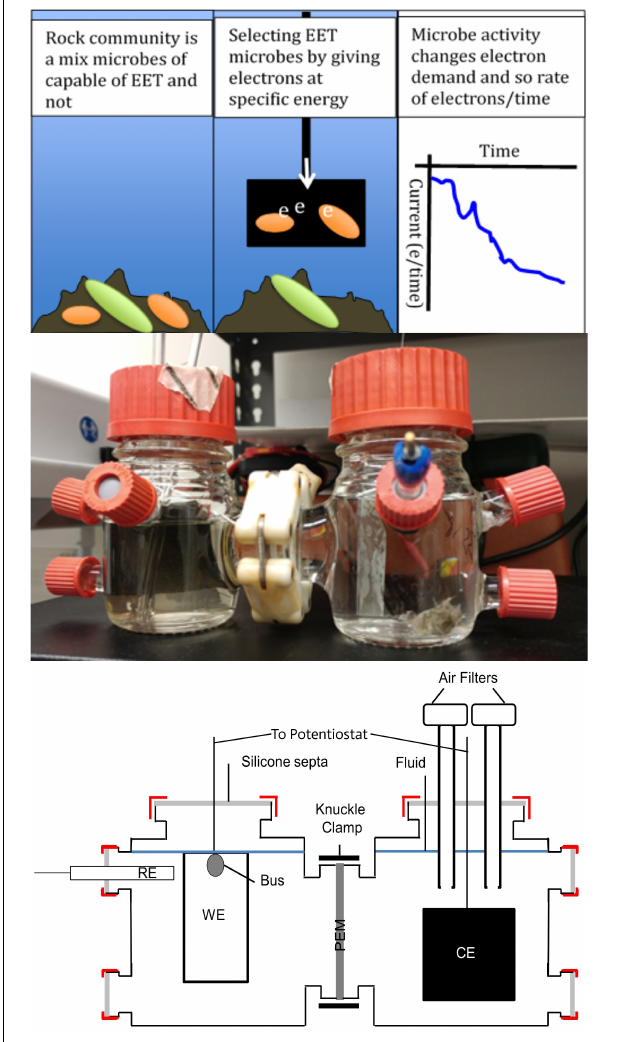
FIGURE 2 | Overview of cathodic poised potential experiments for enriching microorganisms from North Pond subsurface crustal samples capable of extracellular electron transport (EET) when supplied with –200 mV (versus standard hydrogen electrode) and oxygen. Top: Conceptional cartoons of experiment principles. Middle: Photograph of a complete two-cell unit, with reference electrode (RE) and ITO-coated glass working electrode (WE) in the cell on the right and the counter electrode (CE) in the cell on the left separated by a Nafion proton exchange membrane (PEM). Bottom: Schematic of a complete two-cell